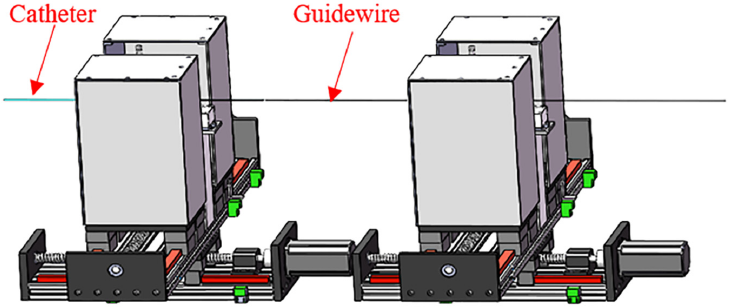
Figure 10. Schematic diagram of the co-operation of the catheter and guidewire.